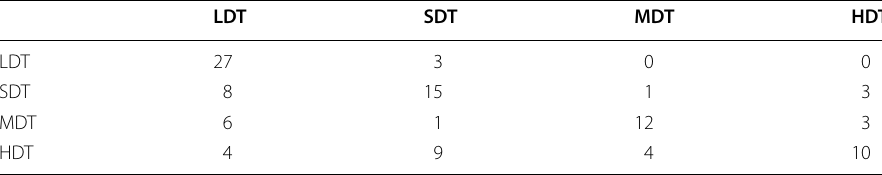
Table 7 Confusion matrix for the Random Forest